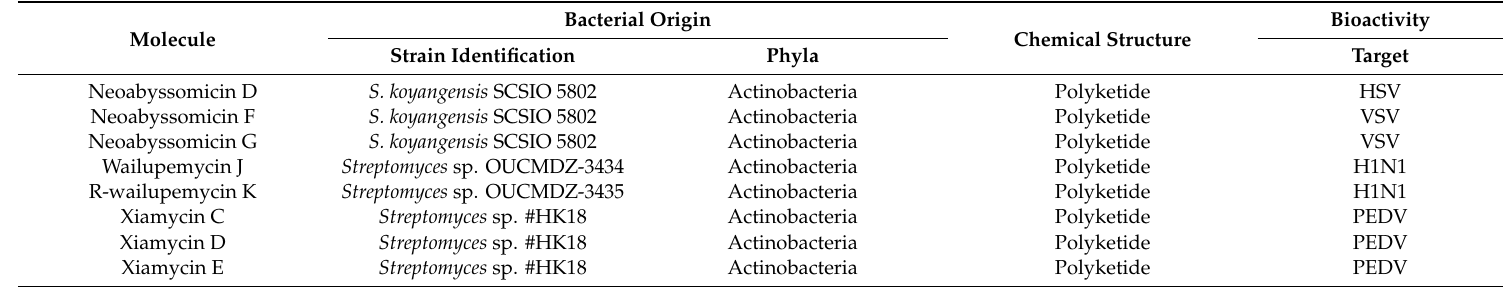
Table 2. Recently isolated bioactive molecules from marine bacteria with antiviral properties.